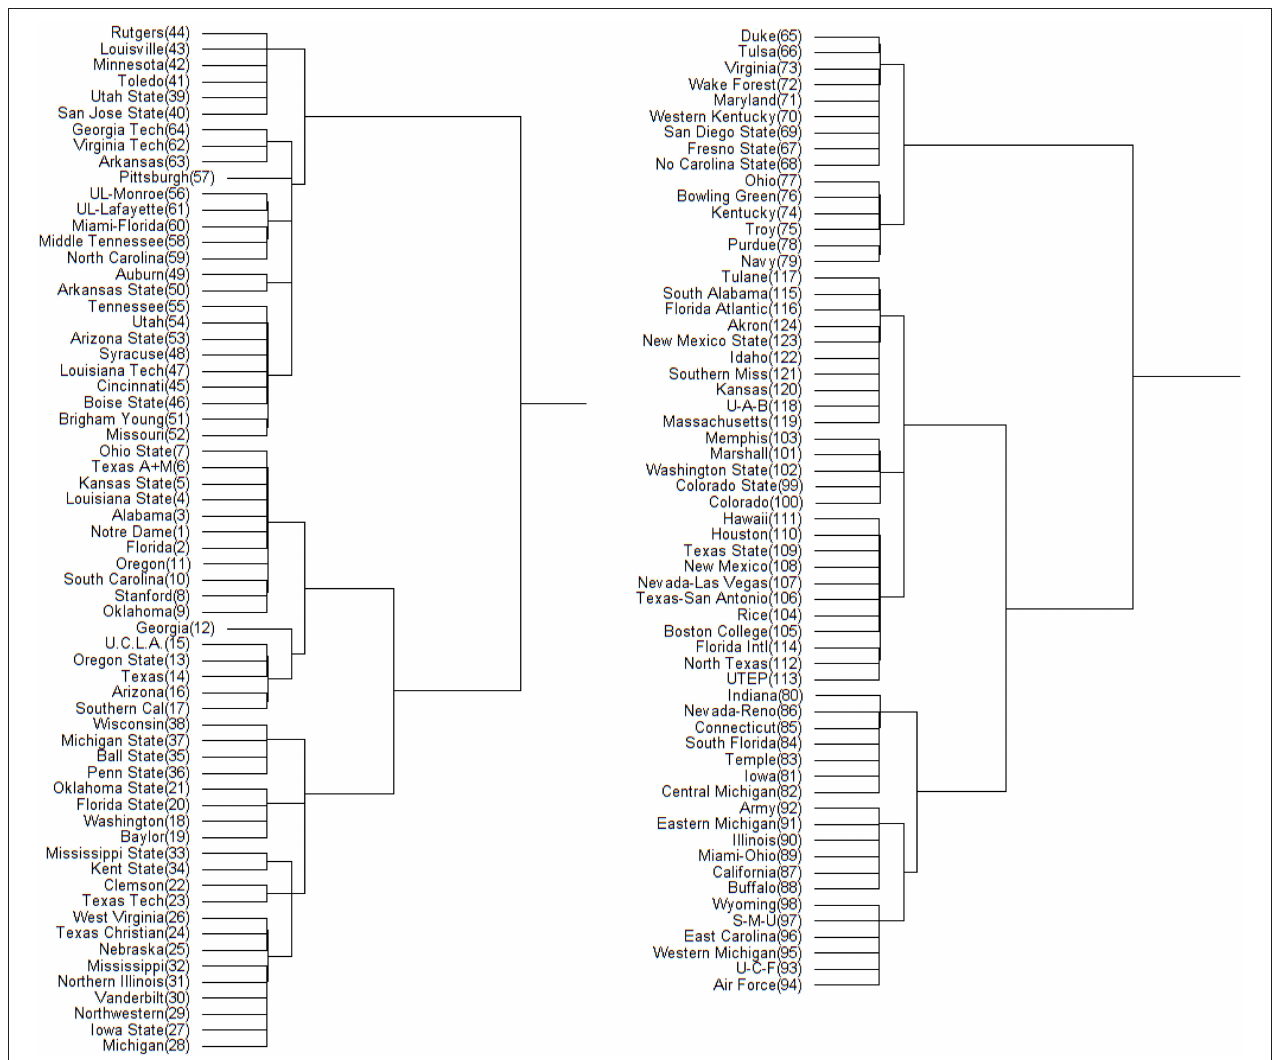
FIGURE 4 | Hamiltonian distance based DCG tree for the 2012 NCAA football season. The tree has been cut at its highest level for ease of presentation. The branch containing the top 64 teams is displayed on left; the remaining teams are displayed on right. The number in the parentheses next to each team name is its position in ˆ σ